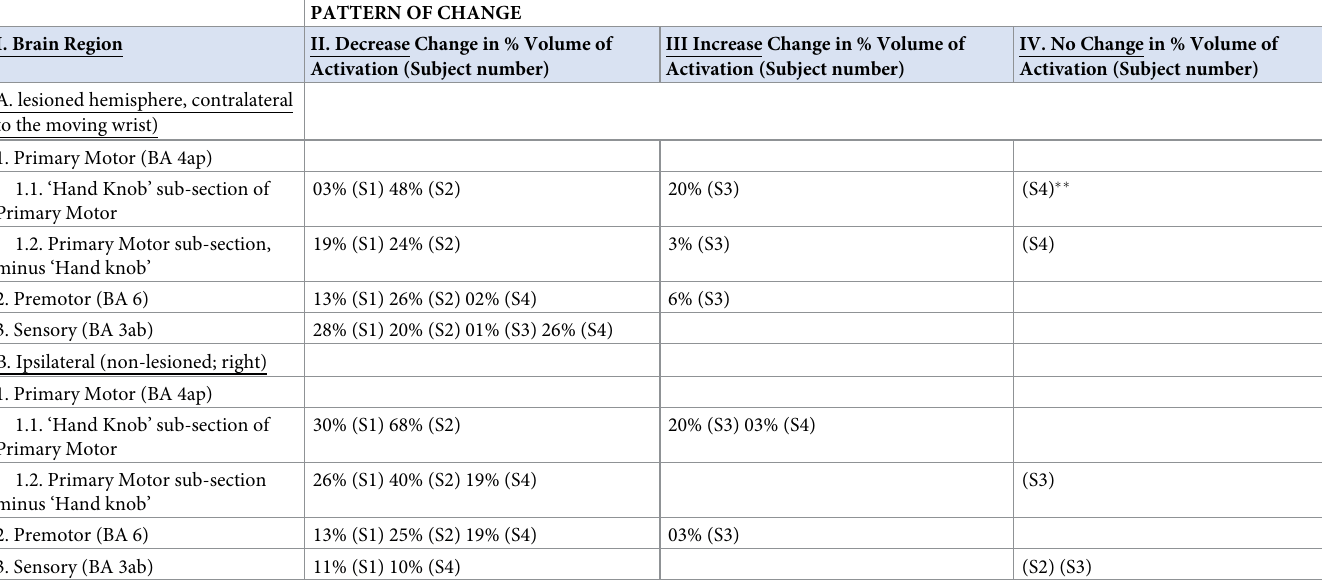
Table 3. Patterns of change from pre-treatment to 3 month follow-up � , according to percent volume of activation; wrist extension motor